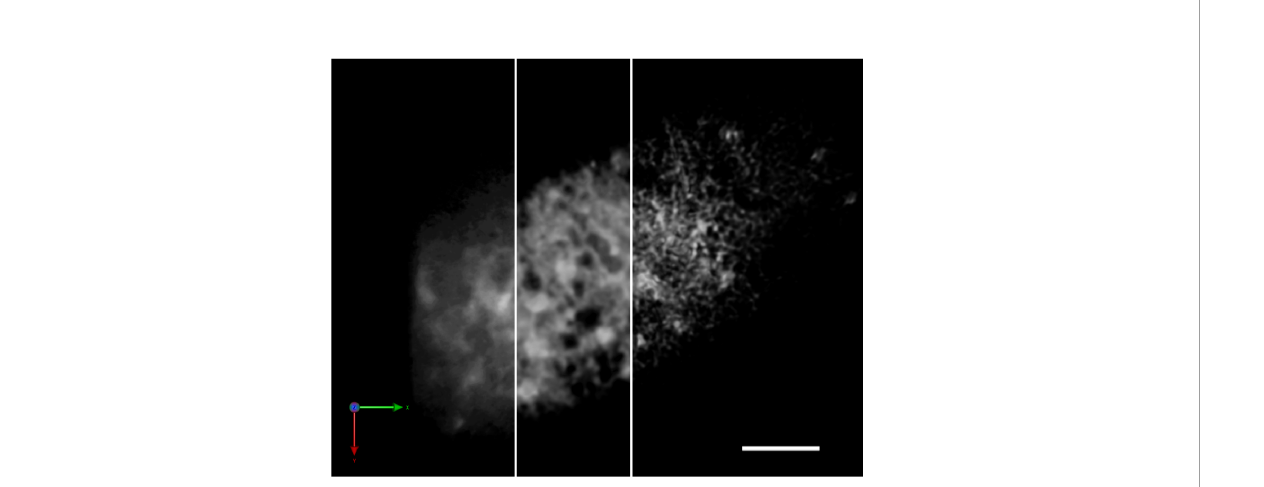
FIGURE 1 Improvement of the spatial resolution of a SCLIM image by repetitive deconvolution. 3D image of the ER in a tobacco BY-2 cell (SP-iRFP-HDEL) taken by SCLIM. The resolution was improved by the iterative restoration (repetitive deconvolution) of Volocity software. Raw image (left), after 5 iterations (middle), and after 10 iterations (right). Sacle bar = 5 m